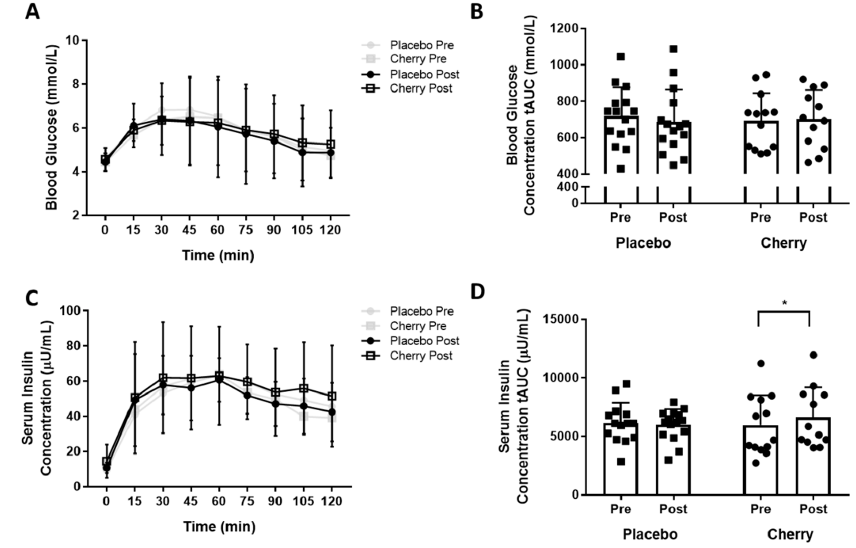
Figure 1. Systemic Glucose and Insulin Responses to an Oral Glucose Tolerance Test (OGTT) in